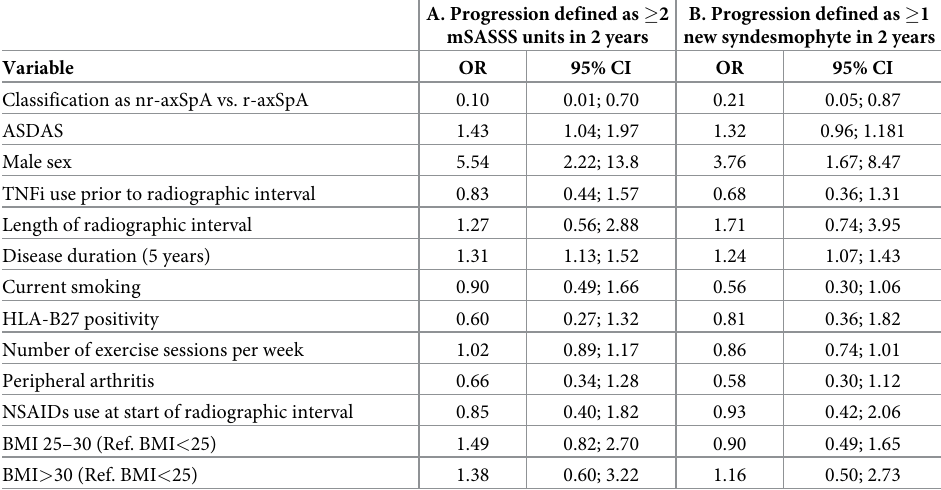
Table 5. Multivariable analysis for the identification of factors associated with spinal radiographic progression in axSpA (model including additional variables).